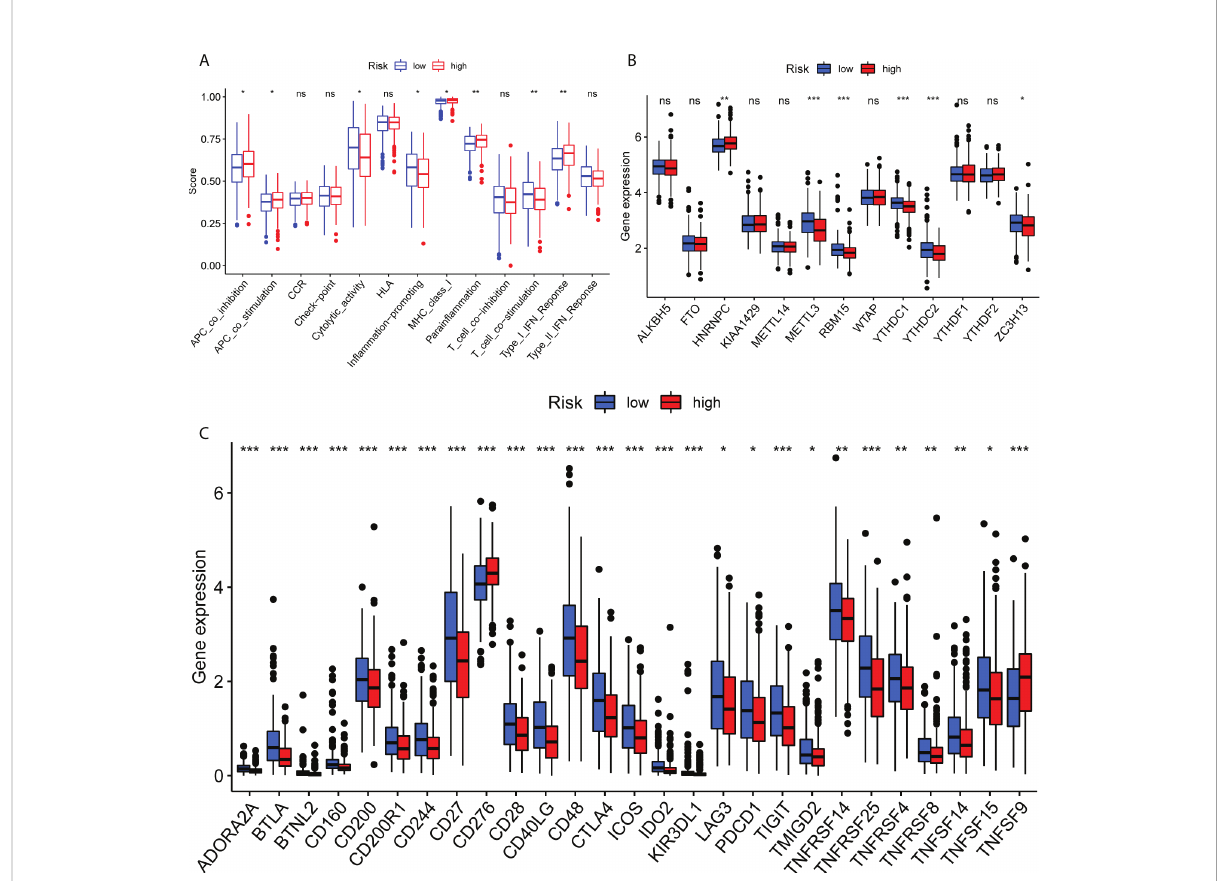
FIGURE 5 Immune function analysis of ferroptosis-related genes in The Cancer Genome Atlas in the lung adenocarcinoma cohort. (A) Single sample gene set enrichment analysis algorithms are shown. (B) Methylation levels are shown. (C) Check points are shown. *P<0.05, **P<0.01 and ***P<0.001. Ns means no signi fi